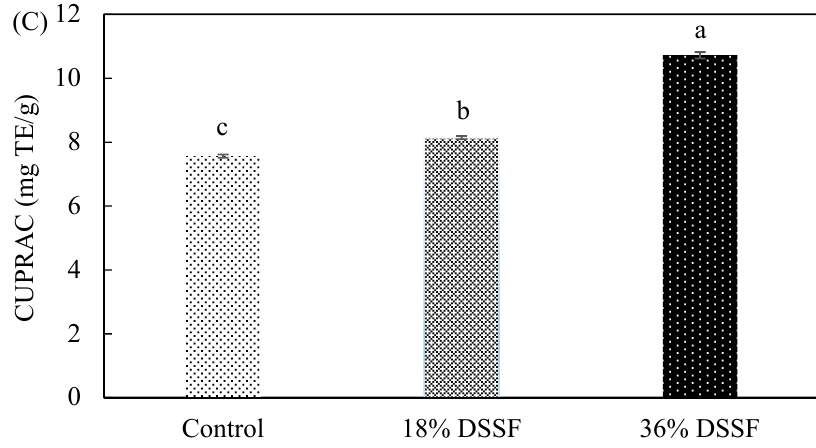
Figure 2. Total phenolic content (TPC) ( A ), DPPH ( B ), and CUPRAC ( C ) values of control and defatted sunflower seed flour (DSSF) biscuits at 18% and 36% inclusion. Data are expressed as means ± SD ( n = 3). Bars with same letter are not significantly different at p < 0.05.